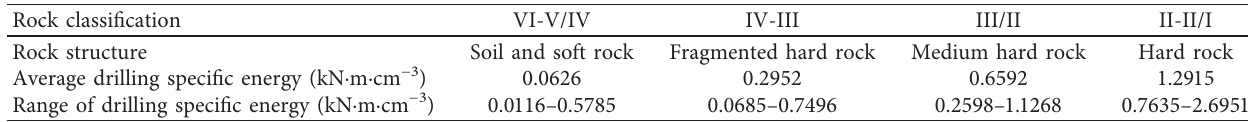
Figure 15: The relationship between rock classification, compressive strength, and drilling specific energy. Table 15: Statistics of rock structure types based on drilling specific energy.